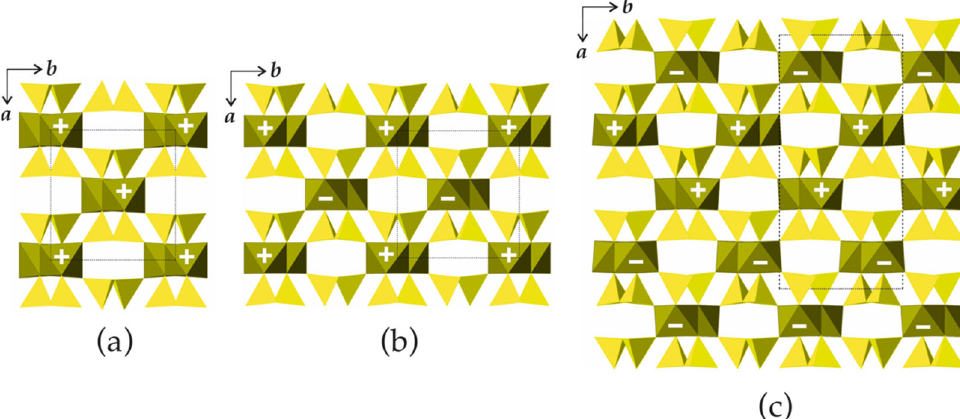
Figure 7. Schematic representation of bipyribole structure types with M = 1 (pyroxenes): the (+) ( a ), (+ –) ( b ) and (+ + – –) ( c ) topological types. Legend: chains of octahedra are in dark ‐ green, Si tetrahedra are in yellow.